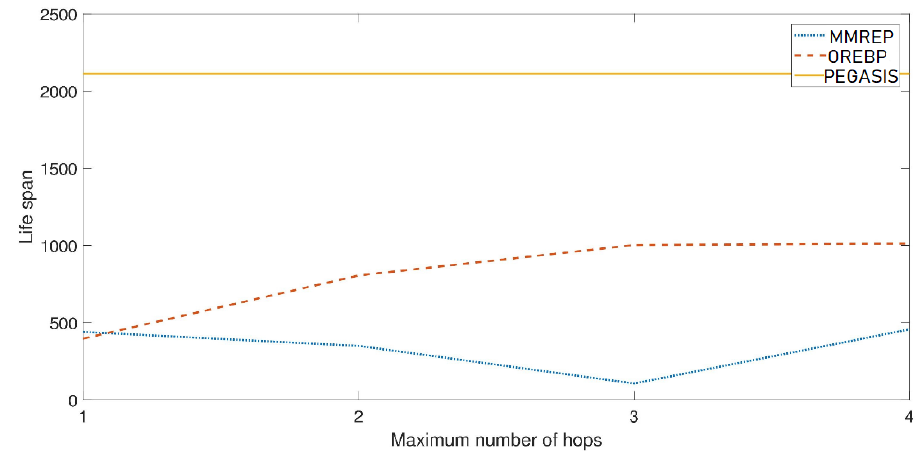
Figure 6. Life span and maximum number of hops ( ε = 0.05 ) .